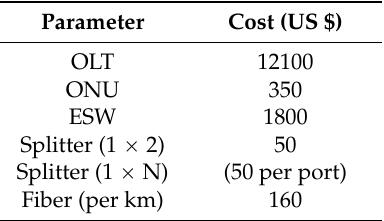
Table 5. Component cost (US $) [22].